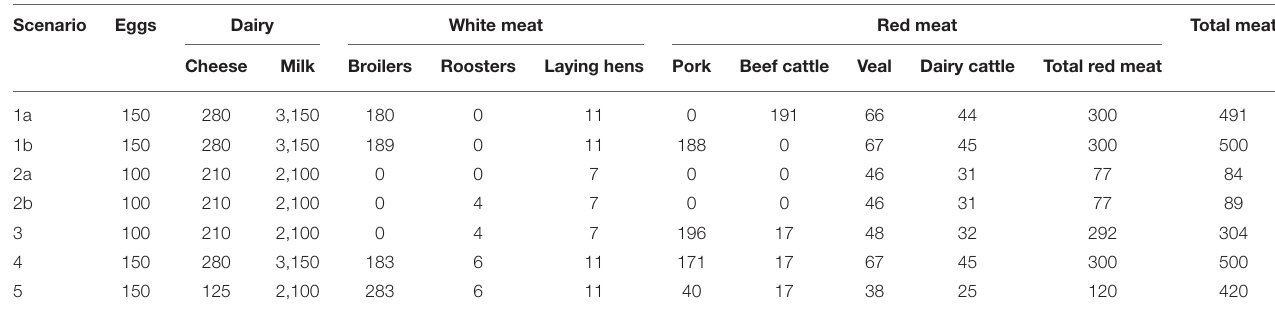
TABLE 3 | Consumption of animal products per scenario in g/week.